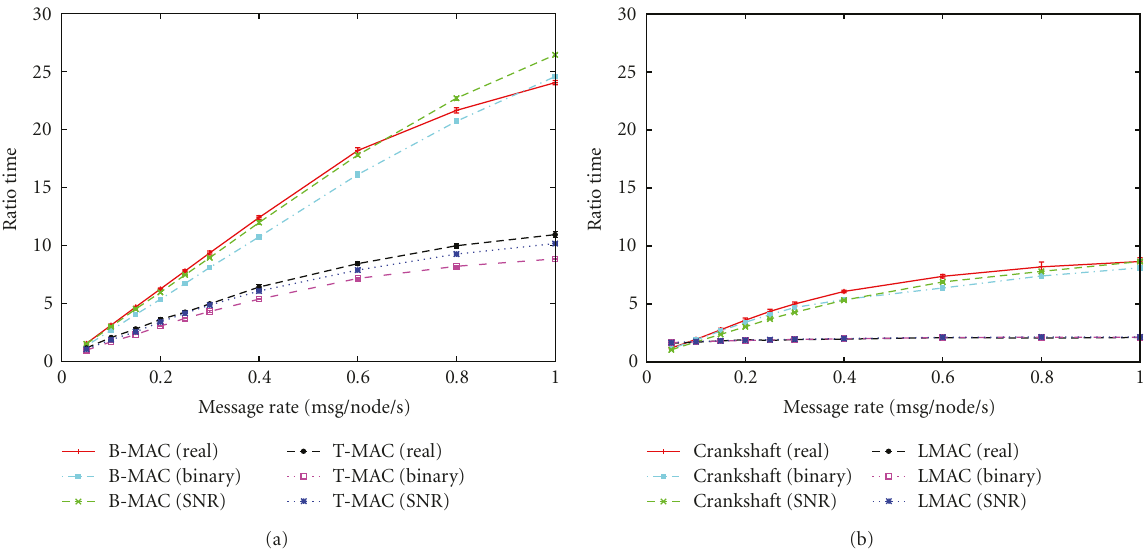
Figure 5: Radio transmit times for simulated and real convergecast